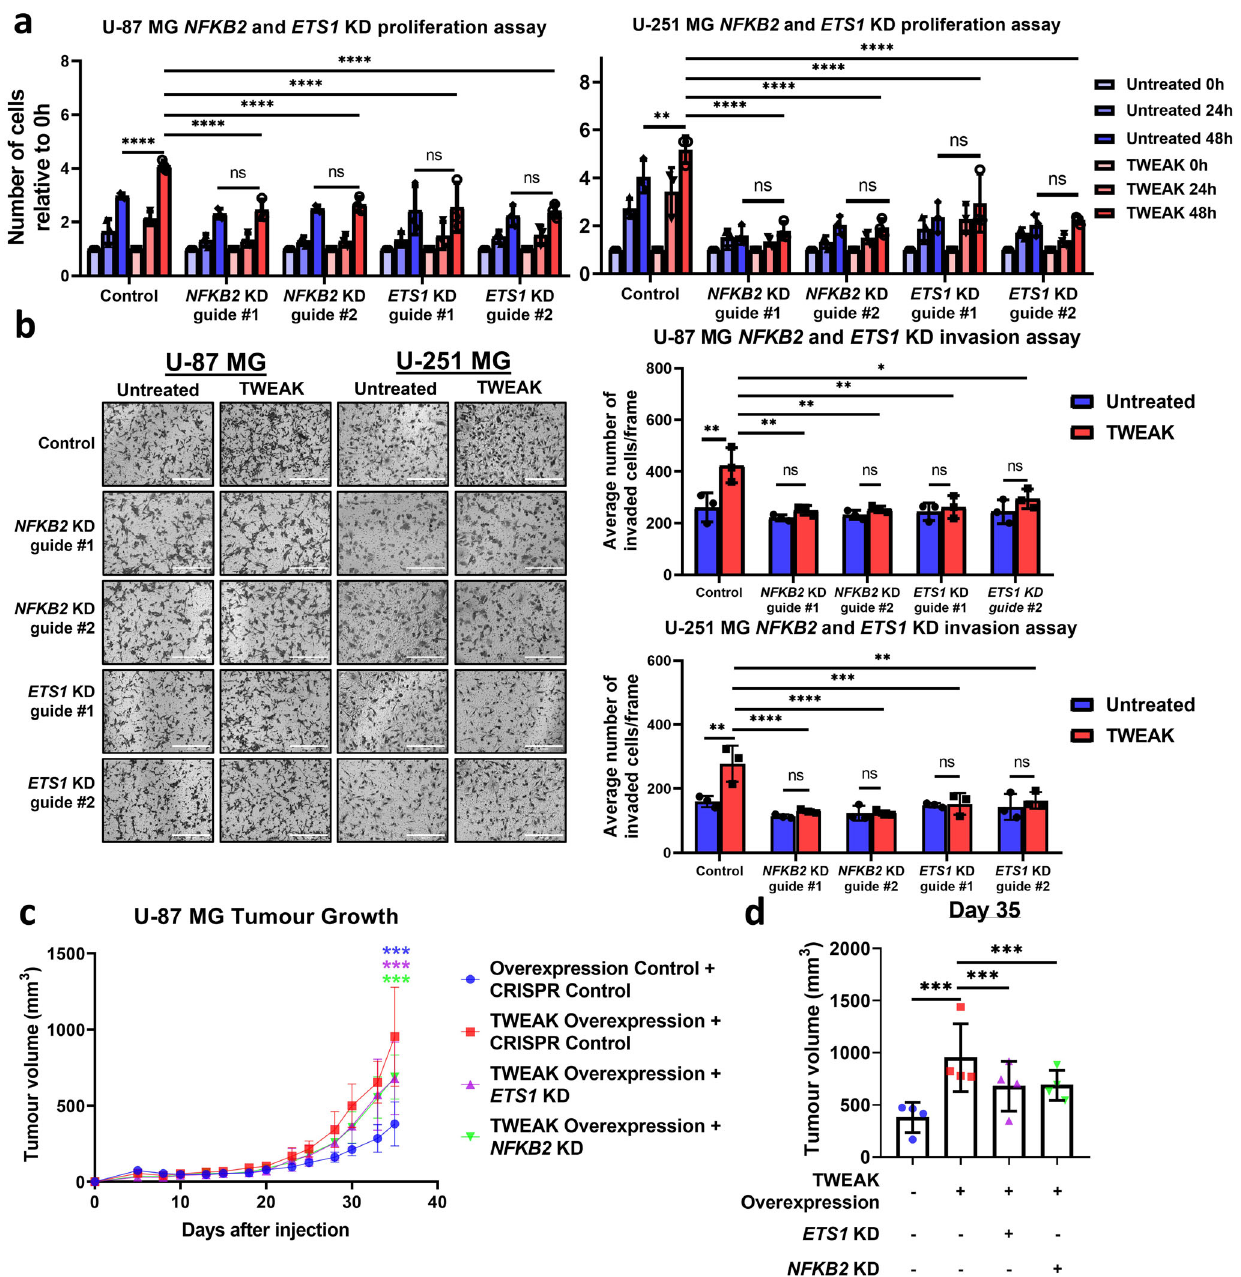
Fig. 3 p52 drives the invasion and proliferation of glioma cells through ETS1. a Proliferation assay plot depicts the average number of cells counted relative to 0 h (mean ± s.d) in U-87 MG and U-251 MG NFKB2 and ETS1 KD cells with and without TWEAK-induced NF- κ B/p52 activation. The data shown represent n = 3 biological replicates. b Transwell invasion assay was performed in U-87 MG and U-251 MG ETS1 KD cells with and without TWEAK treatment. Representative images from n = 3 biological replicates are shown. Scale bars: 400 µ m. Representative plots depict the average number of invaded cells (mean ± s.d) across fi ve fi elds. Representative plots depicting the average tumour volume (mean ± s.d) of U-87 MG cells injected into mice that express either CRISPR control, NFKB2 KD or ETS1 KD and overexpression control or TWEAK c over 35 days and d on day 35. The data shown represent n = 4 mice. Two-way ANOVA was used for all statistical analyses where * P < 0.05; ** P < 0.01; *** P <